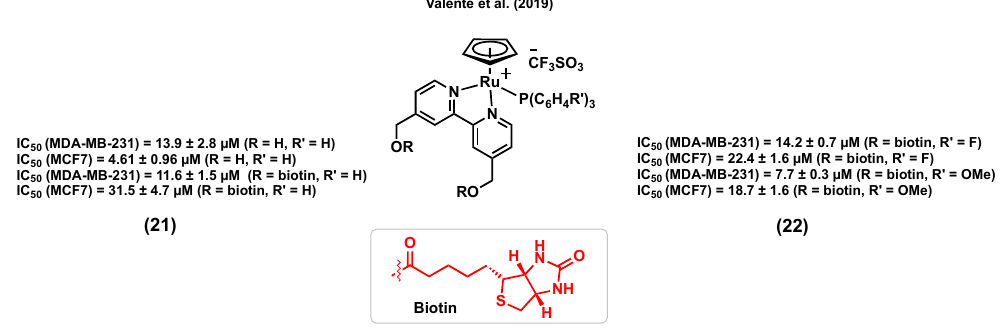
Figure 9. Ruthenium complexes bearing biotin.